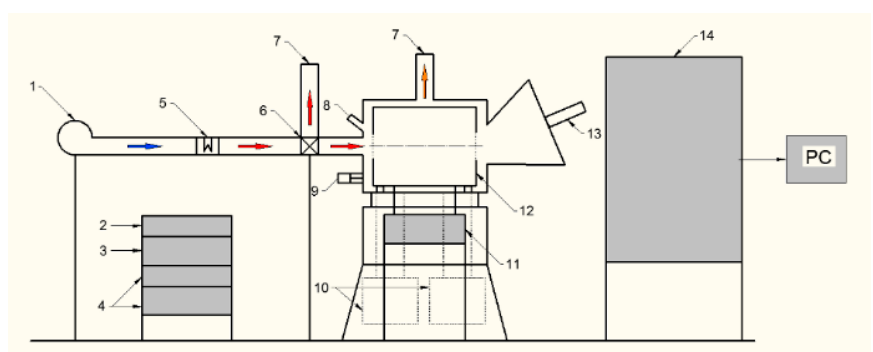
Figure 1. The scheme of the hybrid dryer: 1—blower (fan); 2—AUS controller; 3—AUS preamplifier;